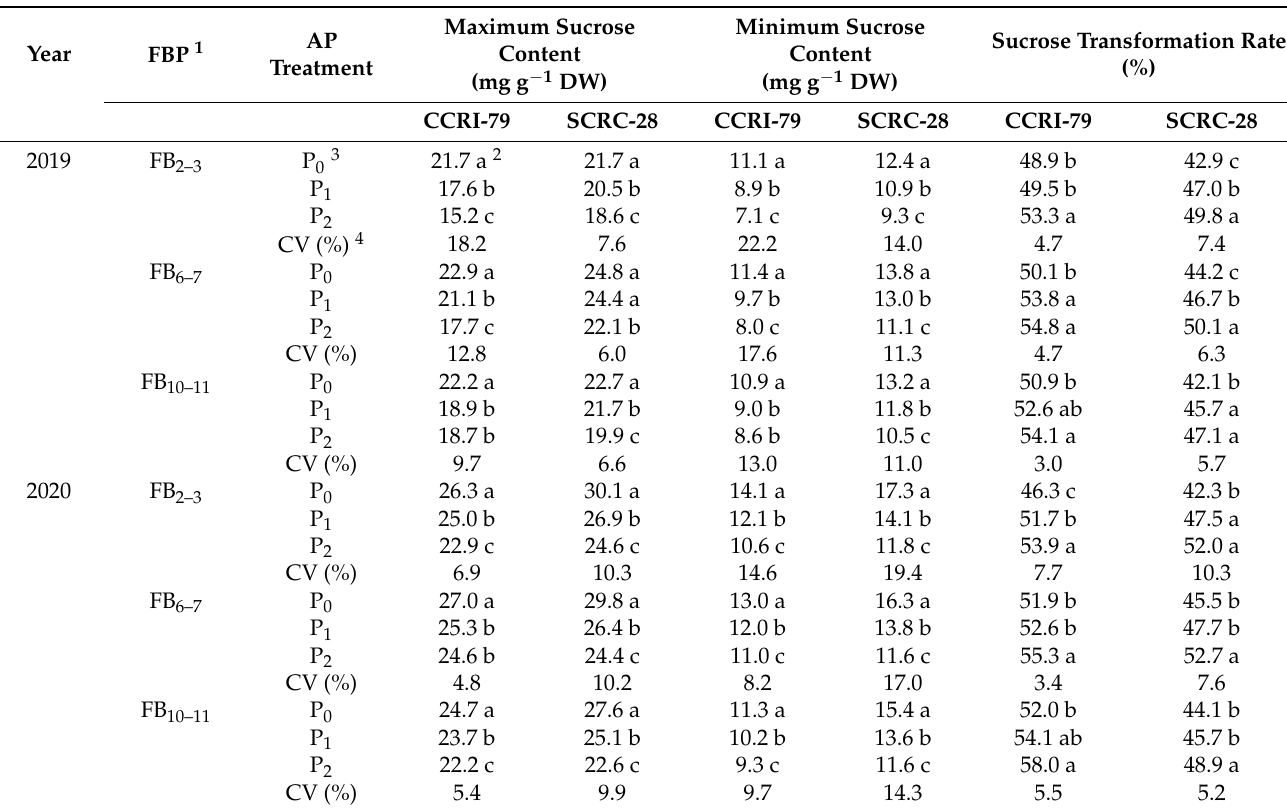
Table 2. The effect of soil available phosphorus (AP) on the maximum and minimum sucrose contents and sucrose transformation rates of subtending leaves in 2019 and